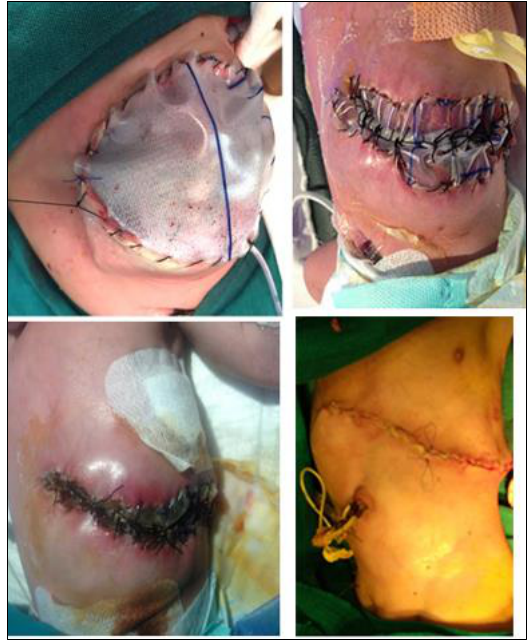
Figure 2: Bogota bag technique of closure of abdominal contents.